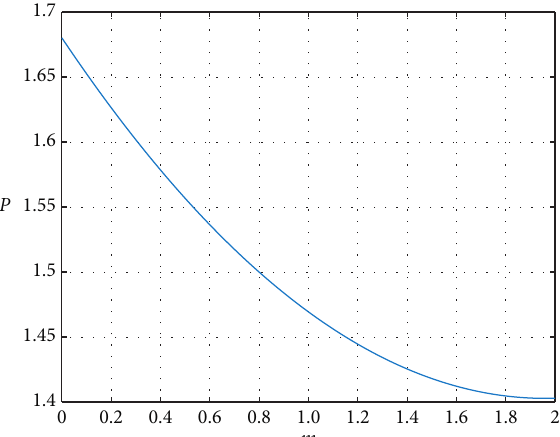
Figure 2: Relationship between self-leadership coefficient m and leadership effectiveness P .